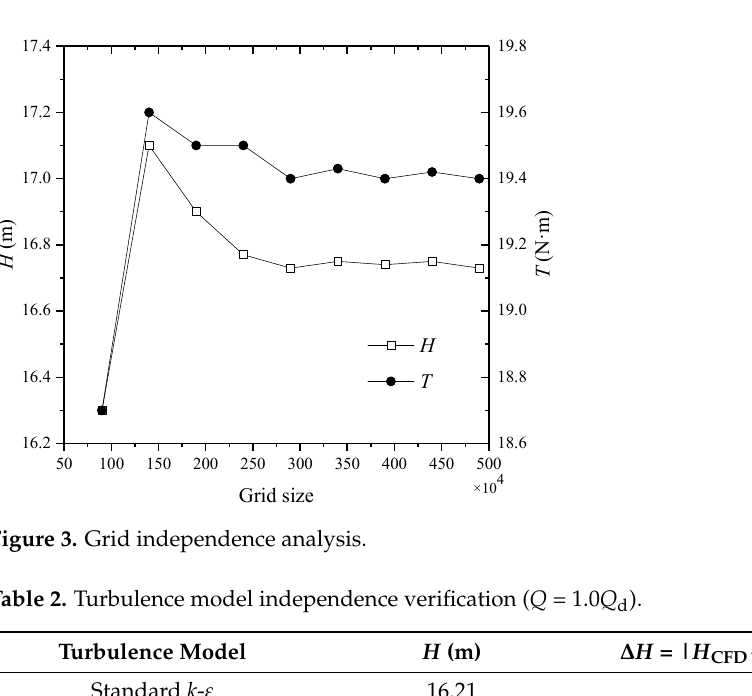
Figure 2. Computational grid of pump model.